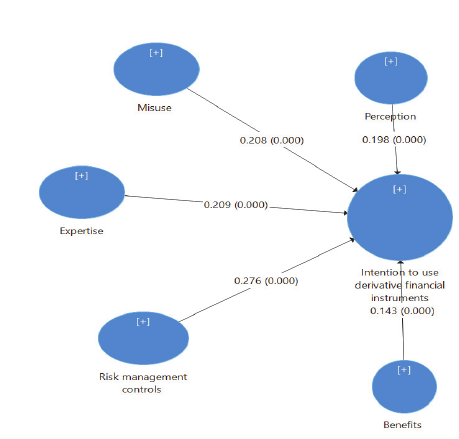
Fig. 2. Research hypothesis test results